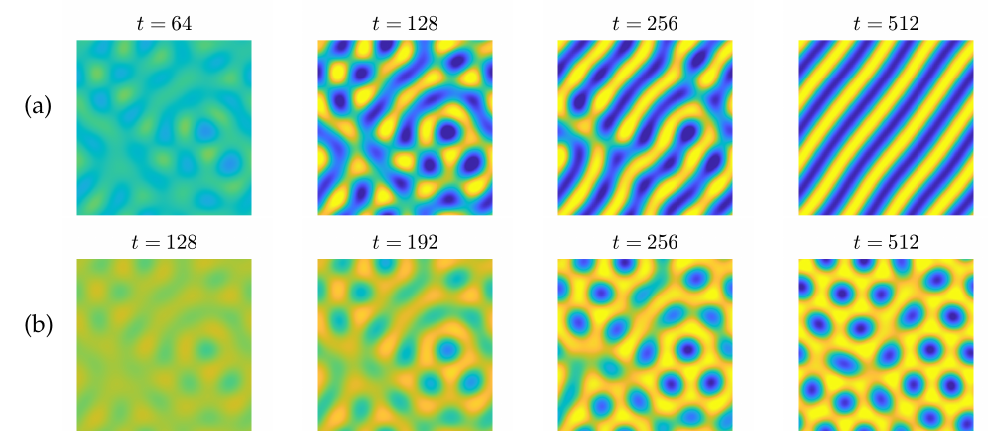
Figure 4. Evolution of φ ( x , y , t ) using the proposed method with ( a ) ¯ φ = 0.02 and ( b ) 0.2. Here, (cid:101) = 0.2, ∆ x = ∆ y = 1 , and ∆ t = 2 are used. The yellow, green, and blue regions show φ = 0.5, 0, and 3 − 0.5, respectively.